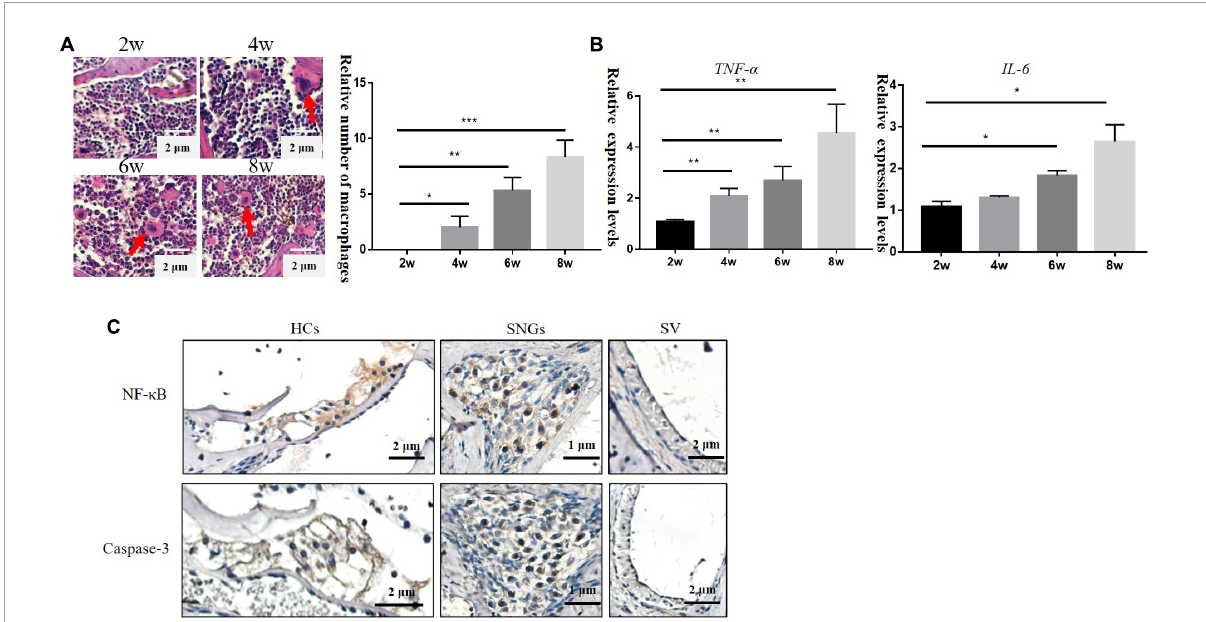
FIGURE3 (A) Inflammatory cells in the lateral wall of the cochlea of DBA/2J mice increased with age, which were mainly macrophages ( × 200). (B) Relative mRNA expression levels of Tnf-a and IL-6. (C) Immunohistochemical: the location expression of NF- κ B and Caspase-3 in the cochlea of DBA/2J mice at 4 weeks (* P < 0.05, ** P < 0.01 *** P < 0.001).